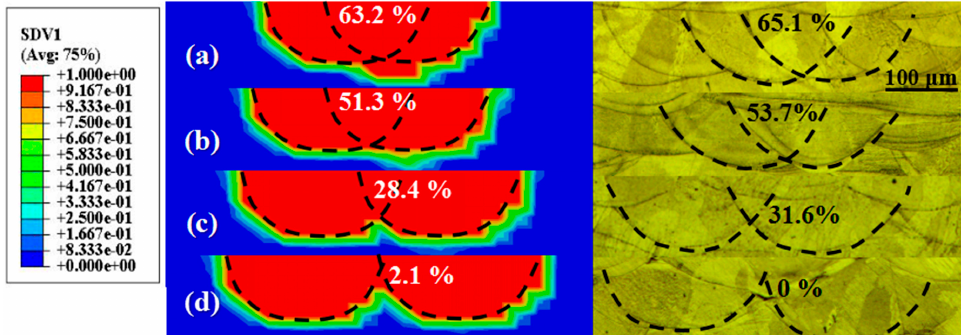
9 of 15 Figure 7. The solidified development at end of the process: ( a ) 75 μ m, ( b ) 100 μ m, ( c ) 150 μ m, and ( d ) 200 μ m. The simulated (left) and experimental (right) results of the overlap rate between adjacent tracks for various hatch spacings are depicted in Figure 8. As seen in Figure 8, the overlap rate decreased with increasing hatch spacing. At the hatch spacing of 75 μ m, the maximum overlap rate calculated with the FEM was 63.2%, and the experimental value was approximately 65.1% (Figure 5a). Moreover, the simulation results show the existence of local over-sintering between adjacent tracks. Qiu et al. [18] reported that a relatively high manufacturing temperature was achieved with relatively low hatch spacings, resulting in excessive fusion of the metal powder and the solid. The size of the repeated melting regions between adjacent tracks increased, and ultimately a comparatively higher overlap rate and corresponding sintering conditions were developed. When the hatch spacing increased to 100 μ m, the simulated and experimental results in Figure 8(b) show a good metallurgical combination. At even higher hatch spacings of 150 and 200 μ m, regions of insufficient melting exist between neighboring tracks, as seen in Figure 8c,d. The calculated overlap rate decreased to 28.4% and 2.1%, and the experimental rate was approximately 31.6% and 0% (Figure 5c,d, respectively). When large hatch spacings were used for SLM, regions of insufficient melting and pores arose between neighboring tracks, owing to the decrease in heat accumulation. According to the above results, the hatch spacing significantly influences the sintering and overlap rate between adjacent tracks.